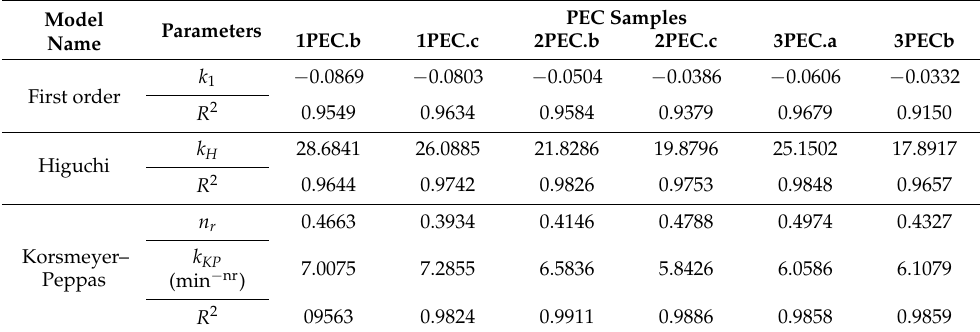
Figure 11. Fitting of kinetic models for the CCM release from 3PEC.a and 3PEC.b cryogels. Table 3. Kinetic parameters for the release of CCM from PEC